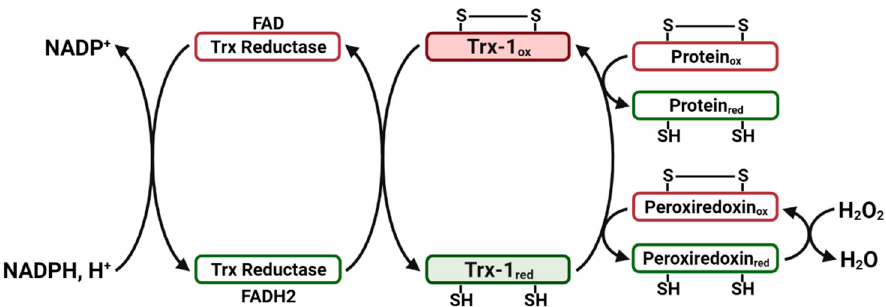
Figure 2. The Redox-Cycling Reactions of the Thioredoxin System. The dithiol moieties of Trx-1 (S-S form) are reduced by receiving electrons from NADPH in the presence of thioredoxin reductase (TrxR). Reduced Trx-1 (SH form) in turn reduces oxidized proteins with disulfide bonds through thiol disulfide exchange reactions. Furthermore, Trx-1 can scavenge free radicals indirectly through peroxiredoxin [157]. Flavin Adenine Dinucleotide (FAD); Nicotinamide Adenine Dinucleotide Phosphate (NADPH 2 ).